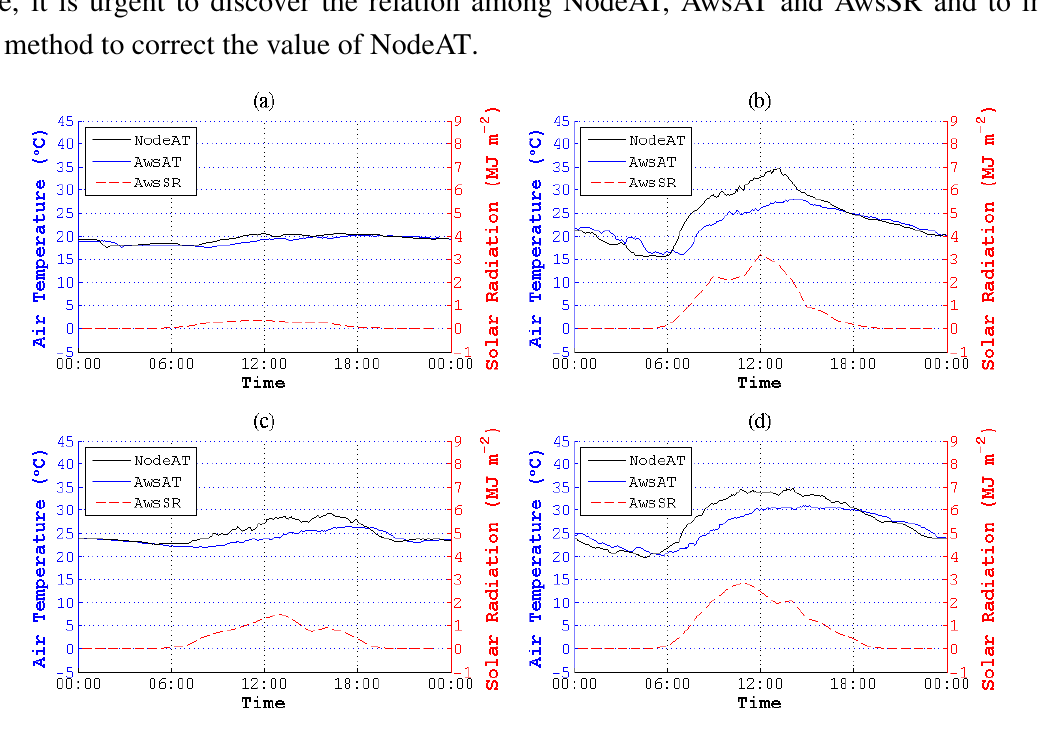
and AwsAT are increasing or decreasing along with the rise or reduction of